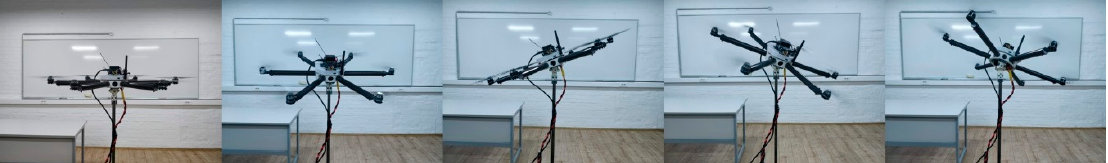
Figure 18. Experimental results of flat quadrotor configuration (FX4) energy consumption.